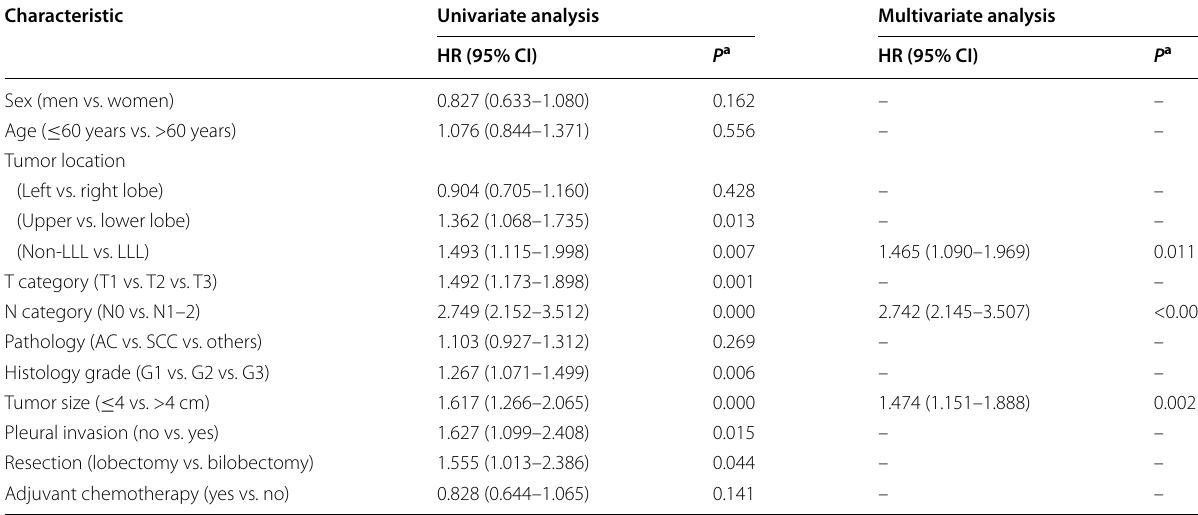
LLL left lower lobe, non-LLL other lobes, AC adenocarcinoma, SCC squamous cell carcinoma, HR hazard ratio, CI confidence interval a